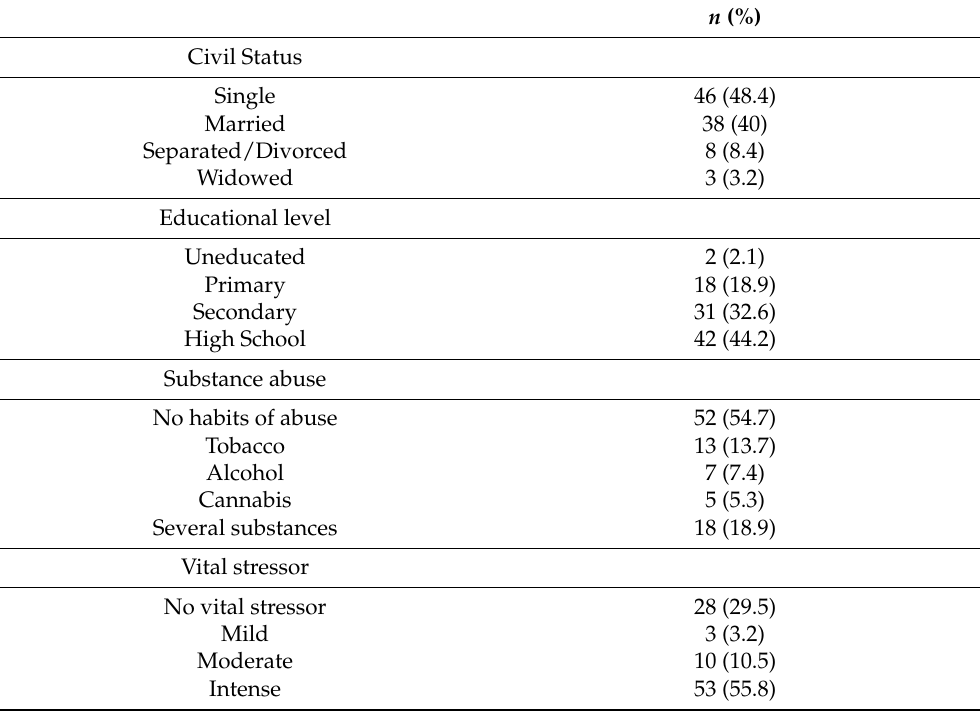
Table 2. Sociodemographic